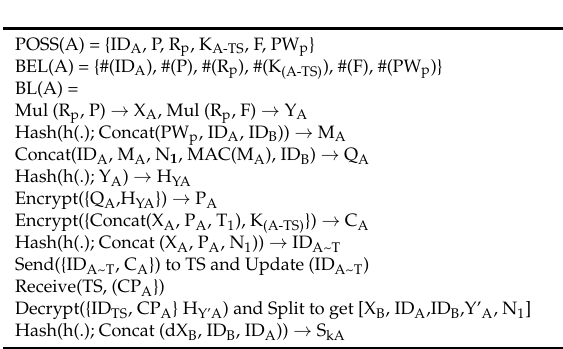
Table 2. Local set at (Patient) (A).